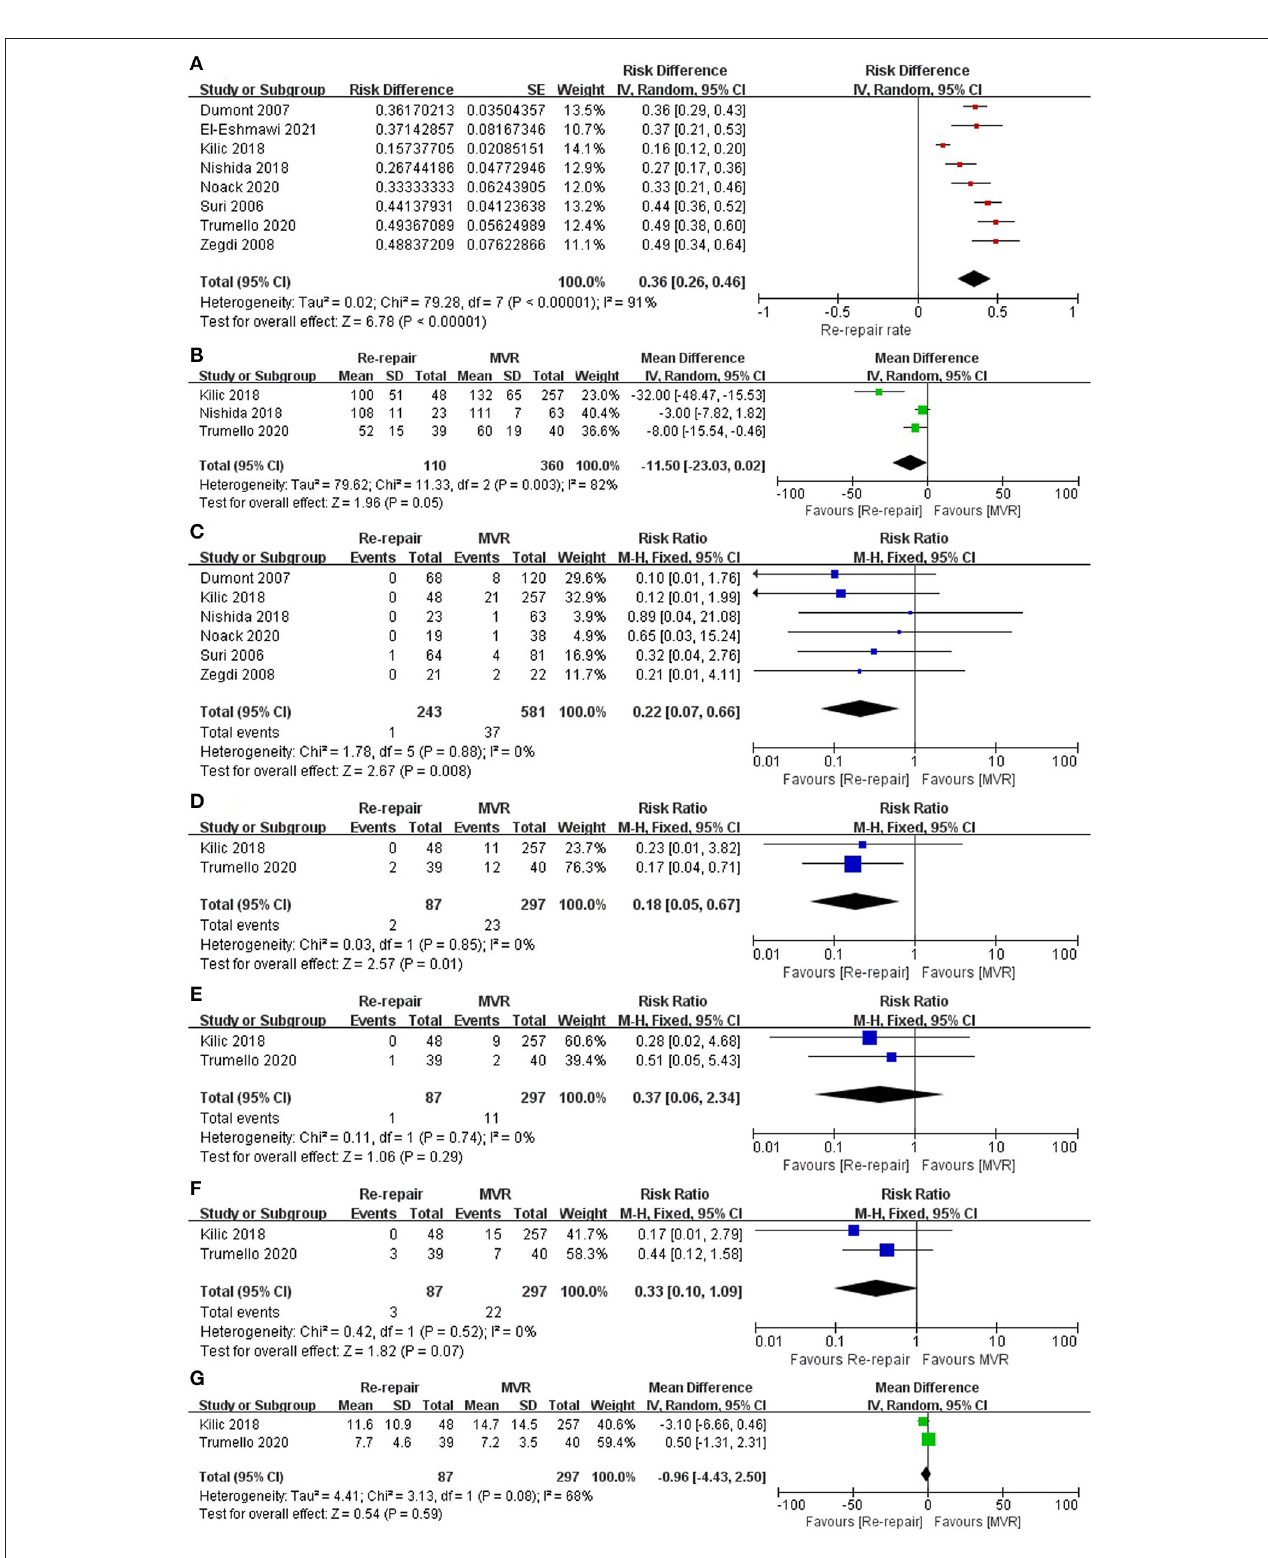
FIGURE 3 | Perioperative outcomes. (A) Re-repair rate for the entire cohort; (B) aortic cross-clamp time; (C) perioperative mortality; (D) AKI; (E) stroke; (F) reoperation for bleeding; (G) postoperative hospital stay. SE, standard error; IV, inverse variance; CI, confidence interval; M-H, Mantel-Haenszel; MVR, mitral valve replacement; AKI, acute kidney